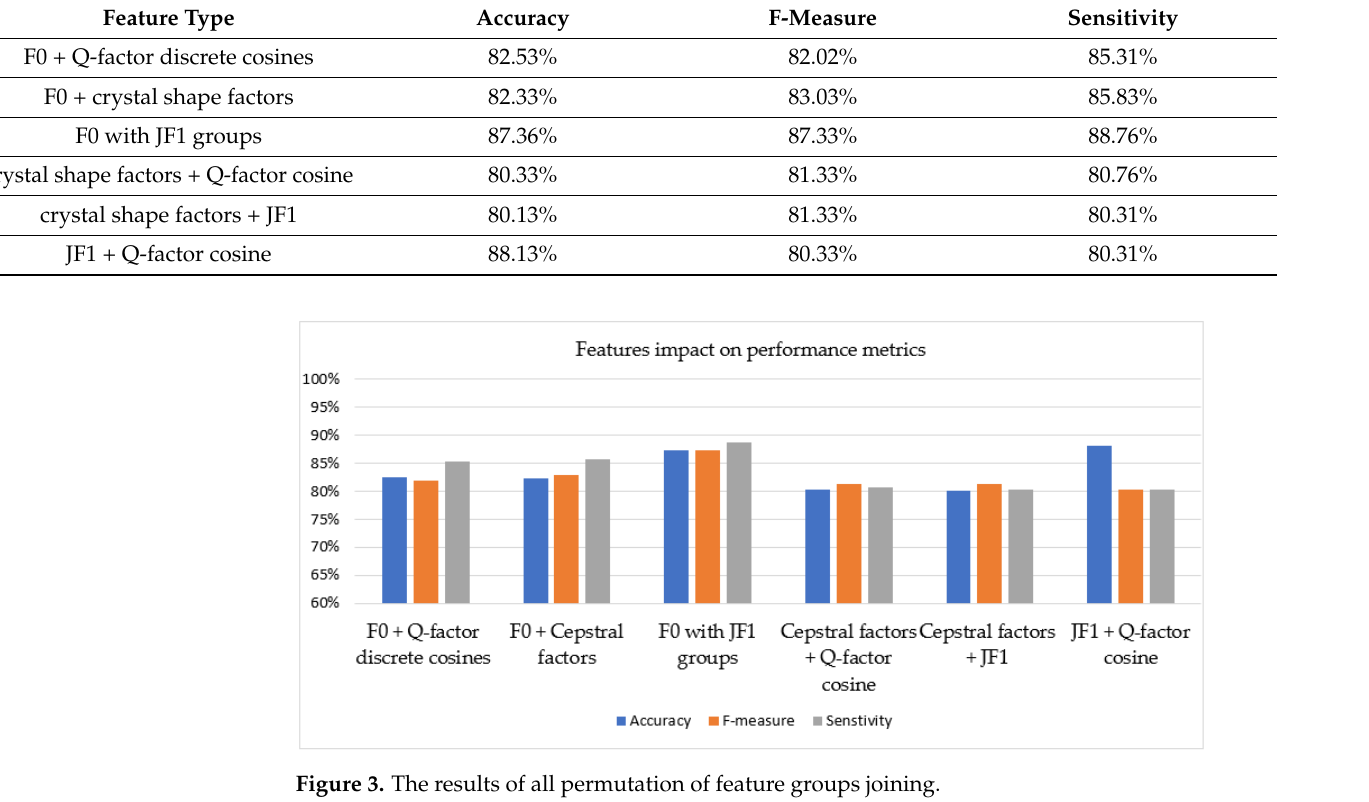
Figure 3. The results of all permutation of feature groups joining.